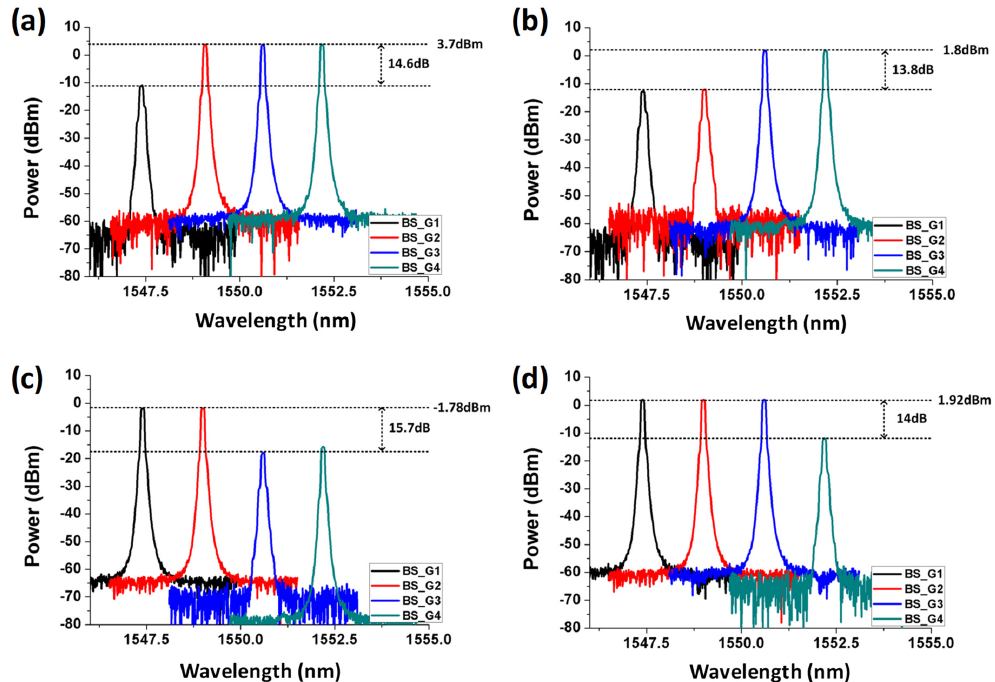
Figure 9. The spectrum measured when the downlink optical signal penetrates ( a ) SBOADM1 and ( b ) SBOADM2 in CW direction and penetrates ( c ) SBOADM3 and ( d ) SBOADM4 in the CCW direction when a breakpoint occurs.